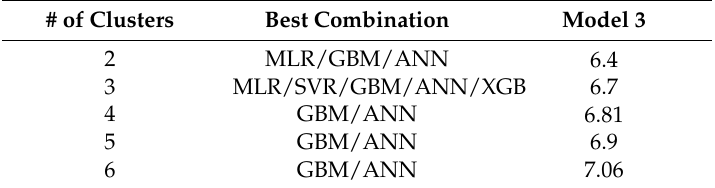
Table 4. Forecasting performance of Model 3 in terms of MAPE according to the number of clusters. # of Clusters Best